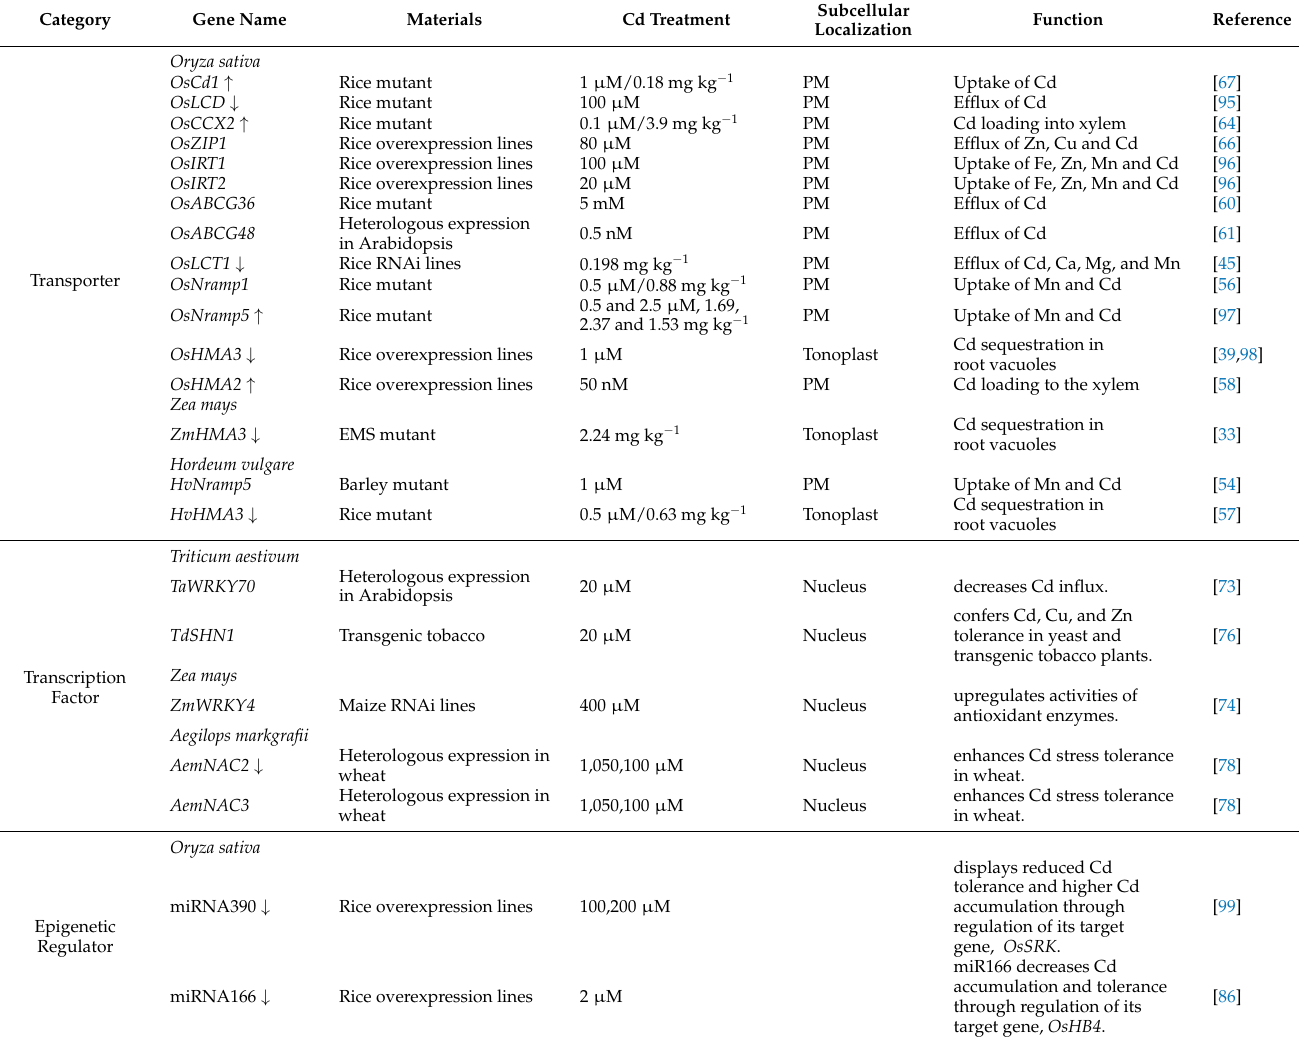
Table 1. Transporters, transcription factors and miRNAs involved in Cd accumulation in cereals.